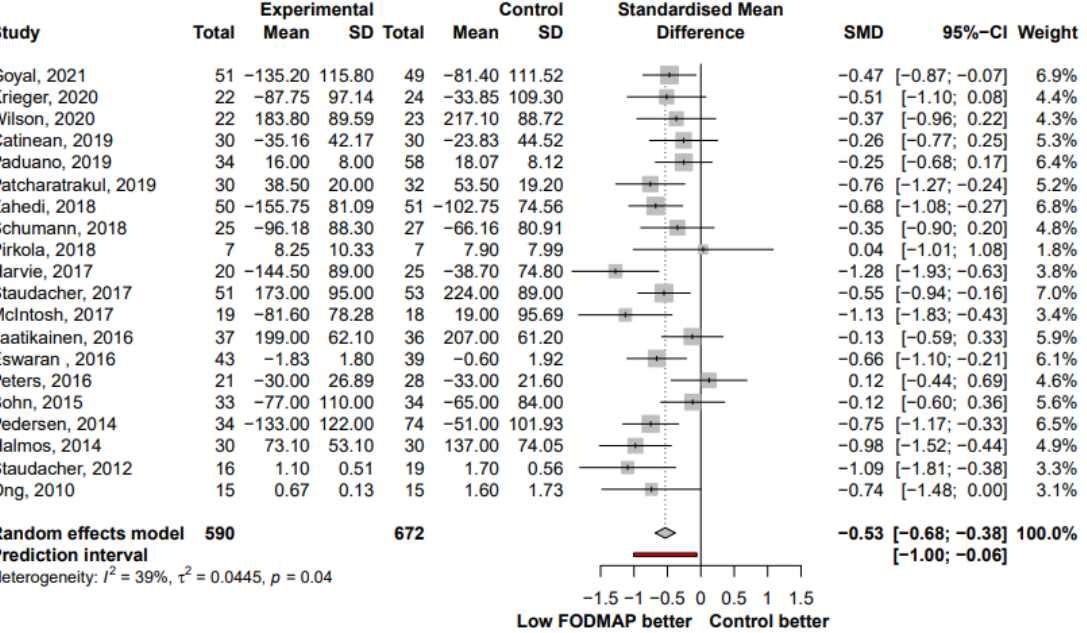
Figure 2. Forest plot showing standardized mean differences for IBS symptom severity reduction. SD, standard deviation; SMD, standardized mean difference; CI, confidence interval.